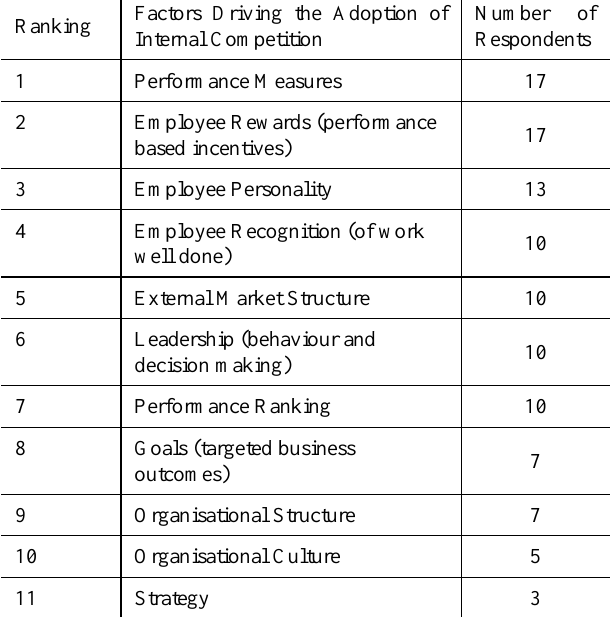
Table 1: Factors driving the adoption of internal